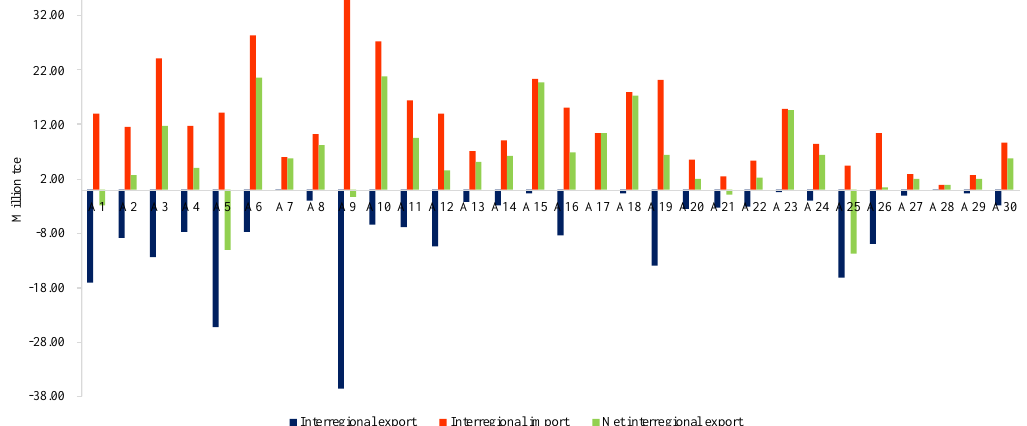
Figure 5. The embodied energy transfer of the transport sector among different provinces.